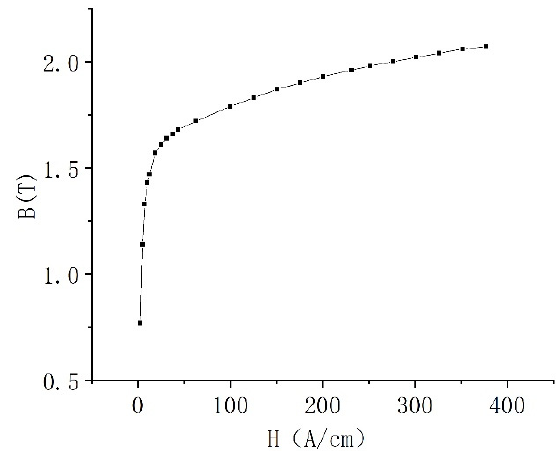
Figure 3. B–H curve of 45# steel.